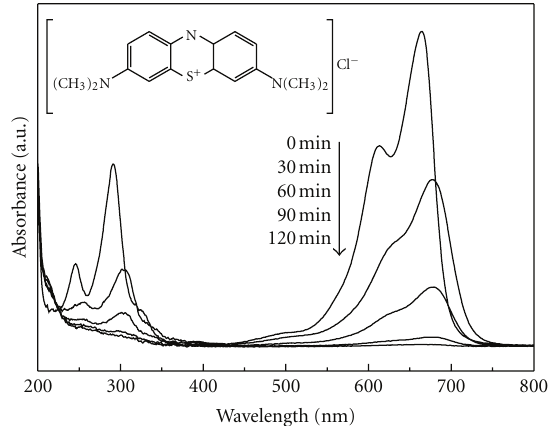
Figure 6: Change of UV-Vis spectra of methylene blue at various reaction intervals for PEC process in the presence of +0.6 V versus SCE anodic bias. Inset is the chemical structure of MB.